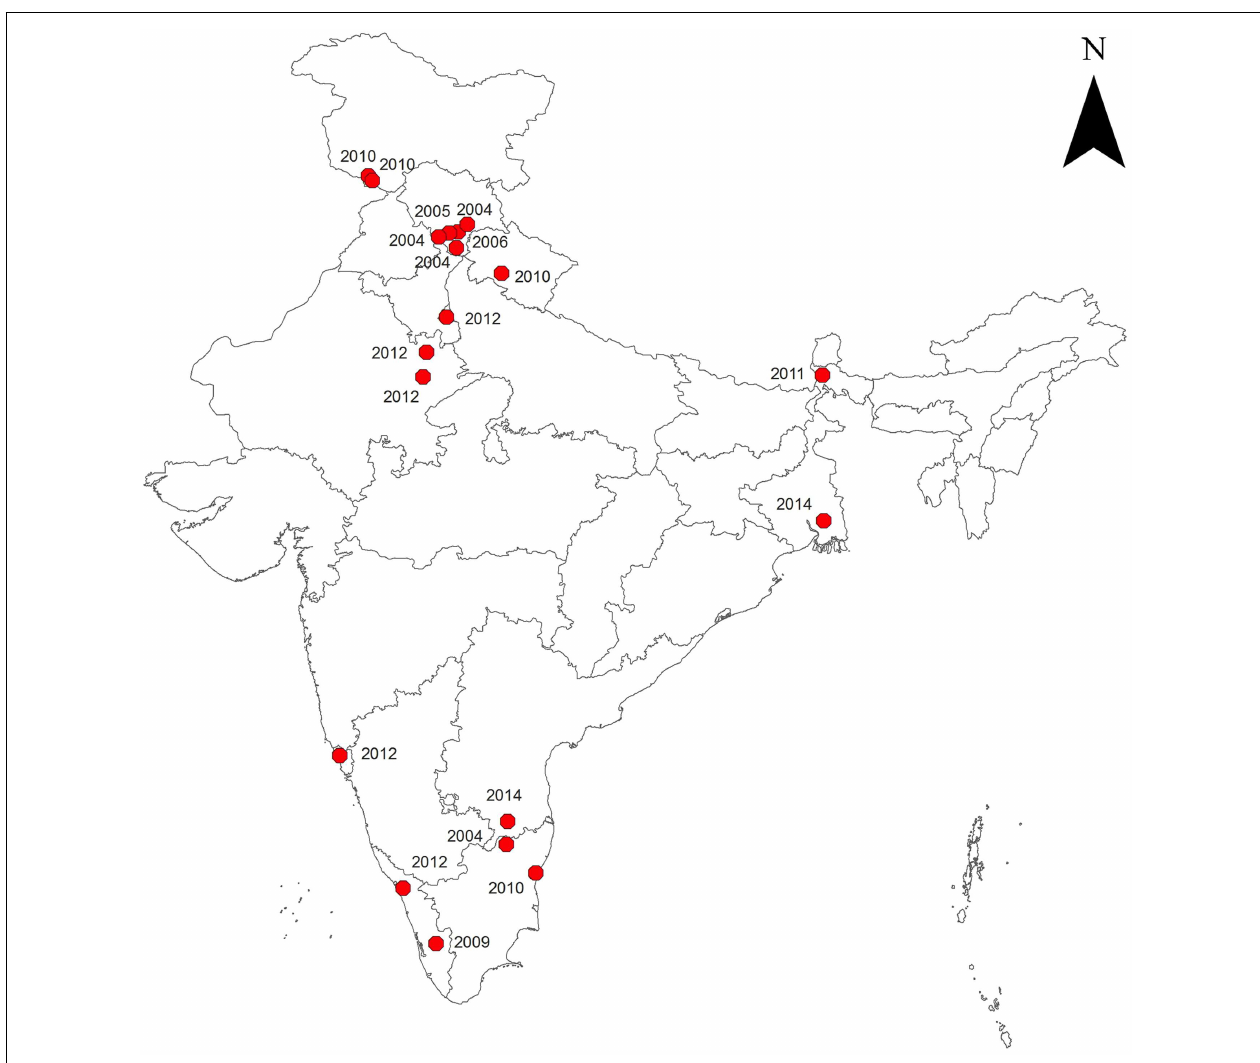
FIGURE 1 | Reported occurrence of scrub typhus in India (2004 onward)